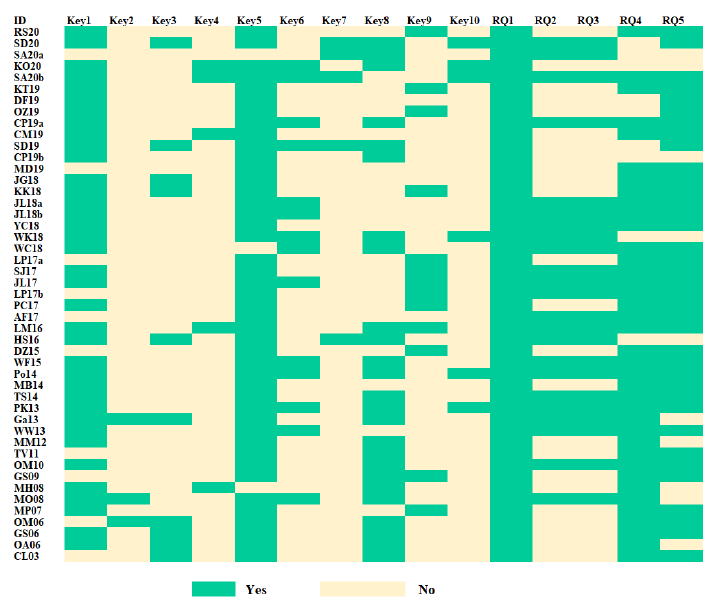
Figure 8. Primary studies answered keywords and research questions.